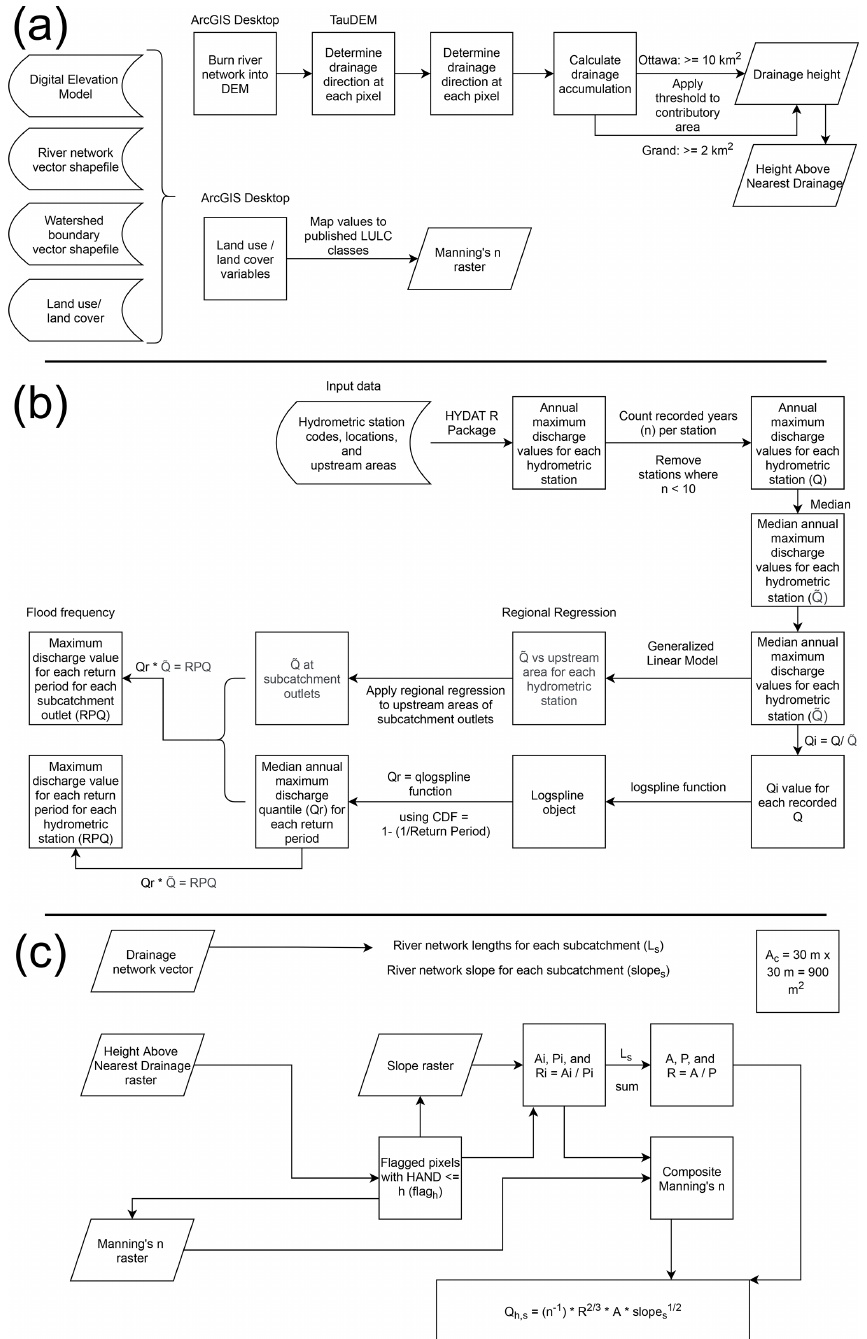
Figure 2. Flood model flow chart illustrating three subphases of overall modeling methodology: (a) GIS pre-processing; (b) flood frequency analysis and regional regression; and (c) HAND-based solution of Manning’s